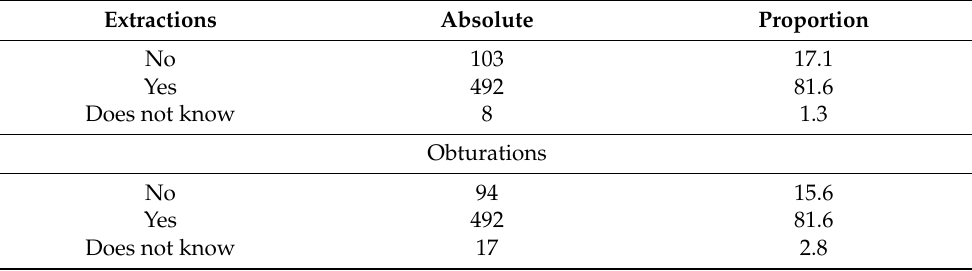
Table 4. Oral procedures.